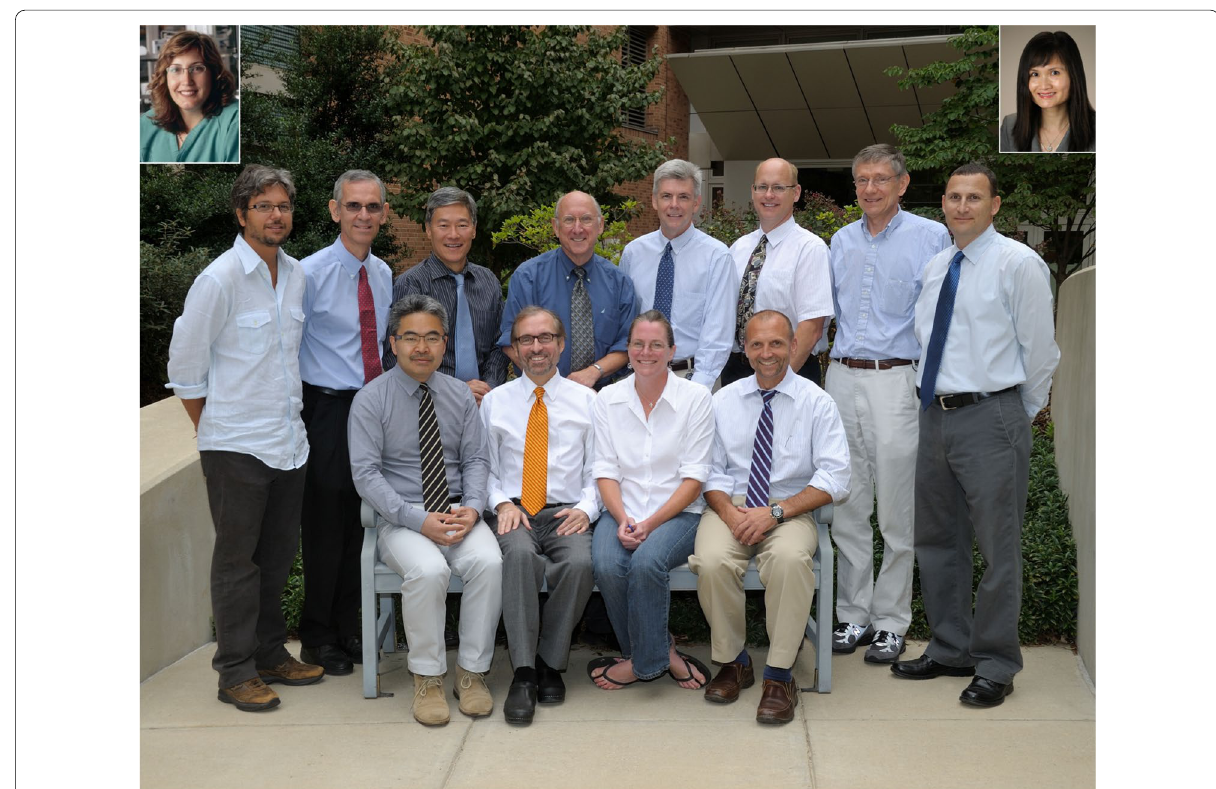
Fig. 6 Immunotherapy staff in the Surgery Branch in 2006. Front row: Ken-ichi Hanada, Nicholas P. Restifo, Maria R. Parkhurst, Mark E. Dudley. Second row: Luca Gattinoni, Paul F. Robbins, James C. Yang, Steven A. Rosenberg, Richard M. Sherry, Richard A. Morgan, John R. Wunderlich, Steve A. Feldman. Inserts: Marybeth S. Hughes, Giao Q.